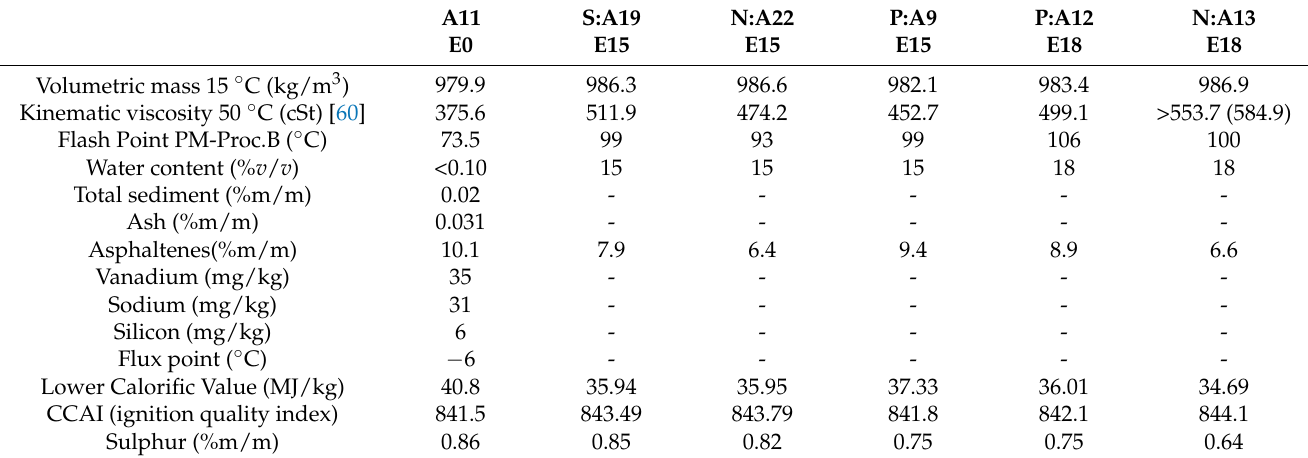
Table 10. Samples of emulsion in several experiments and parameters measured.